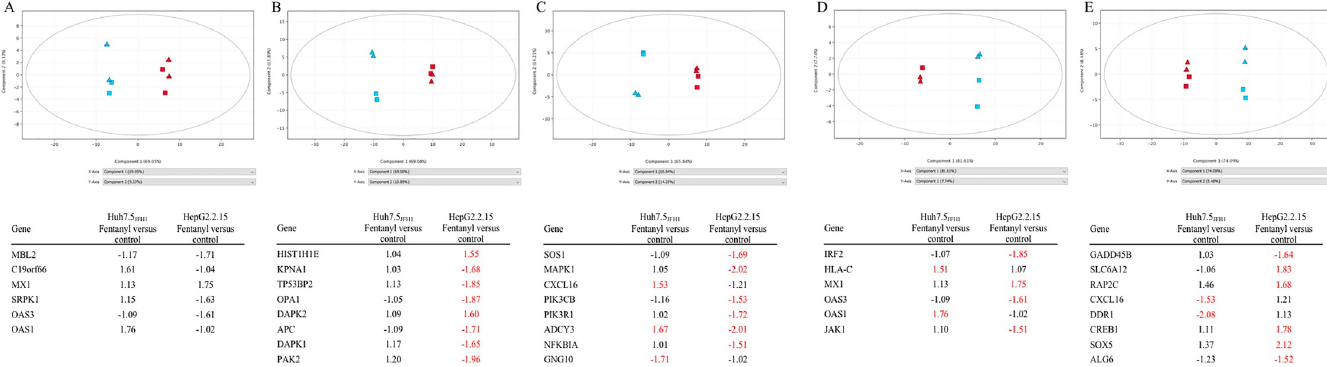
Fig 8. Principle component analysis of mRNA expression data from the Huh7.5 JFH1 and HepG2.2.15 hepatocyte cell lines in the presence / absence of fentanyl. (A) Antiviral, (B) cell death, (C) chemokine, (D) interferon, and (E) NF κ B signaling genes sorted by cell line (red = Huh7.5 JFH1 and blue = HepG2.2.15) and drug treatment (square = no fentanyl and triangle = fentanyl treated). Statistically significant fold changes are highlighted in red.